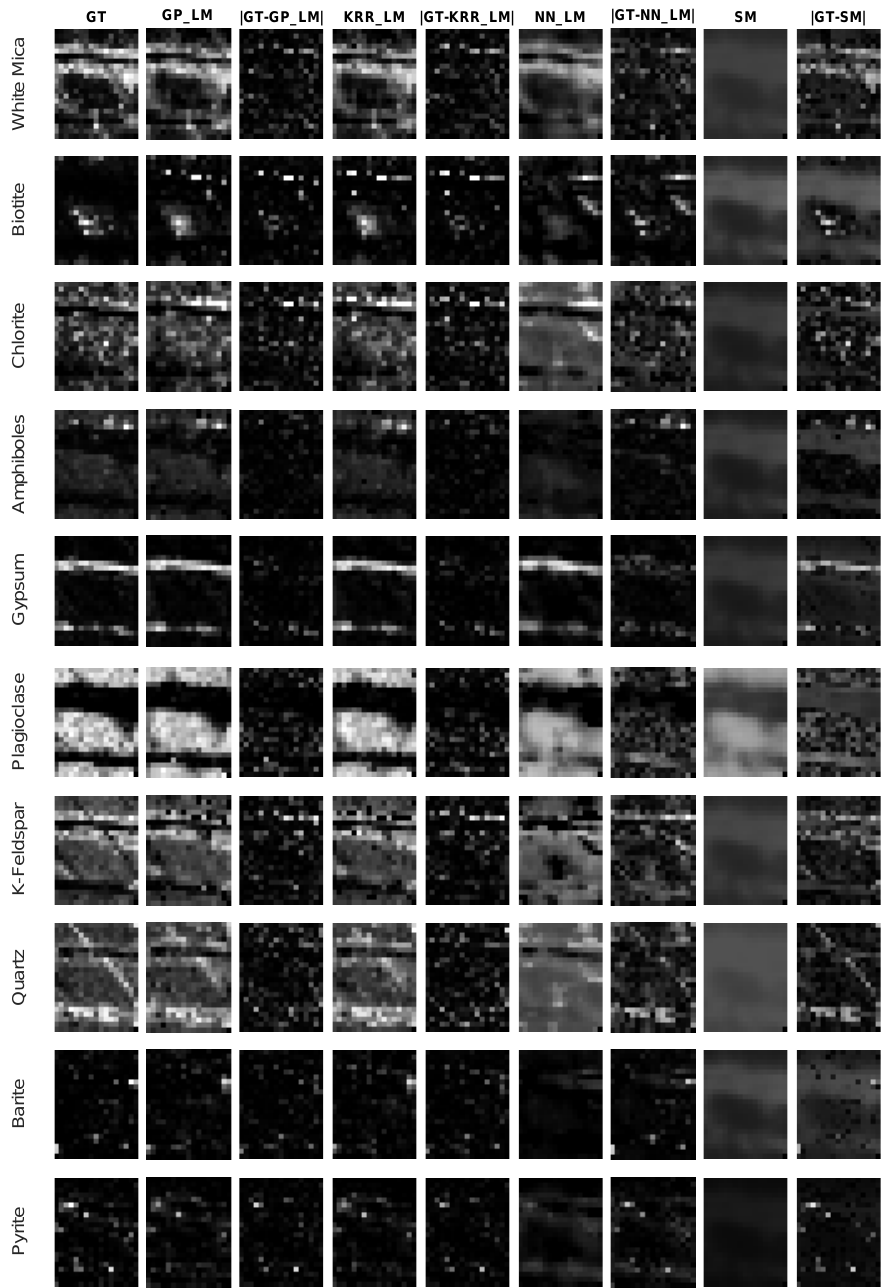
Figure 11. Estimated abundance maps and absolute differences with the ground truth for the four supervised methods on the drill core dataset. All images are normalized by the largest abundance value in the GT